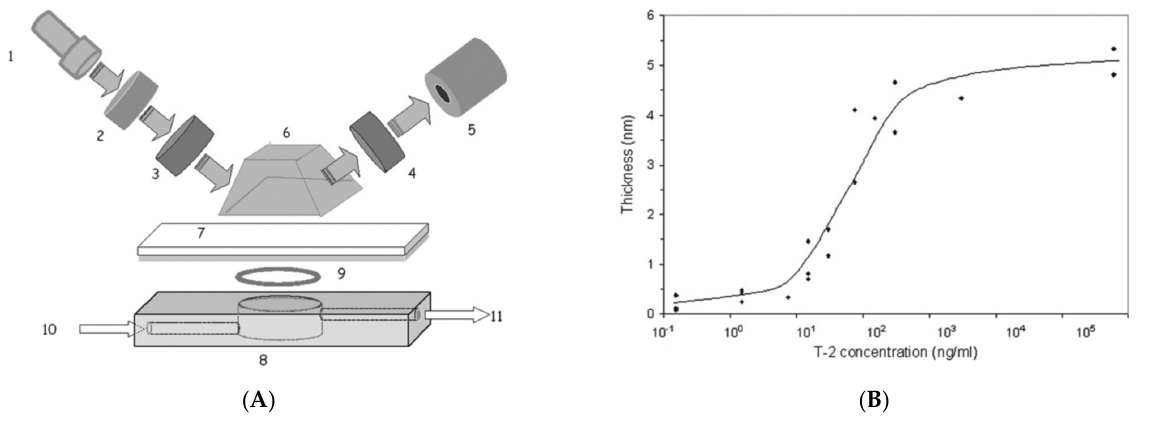
Figure 4. ( A ) Optical configuration of total internal reflection ellipsometry and ( B ) its measurement result for the adsorbed layer thickness on the concentration of T ‐ 2 mycotoxin originated from Ref. [24]; 1, the light source; 2, monochromator; 3, polarizer; 4, analyzer; 5, photodetector; 6, glass prism; 7, Cr/Au coated glass slide; 8, cell.